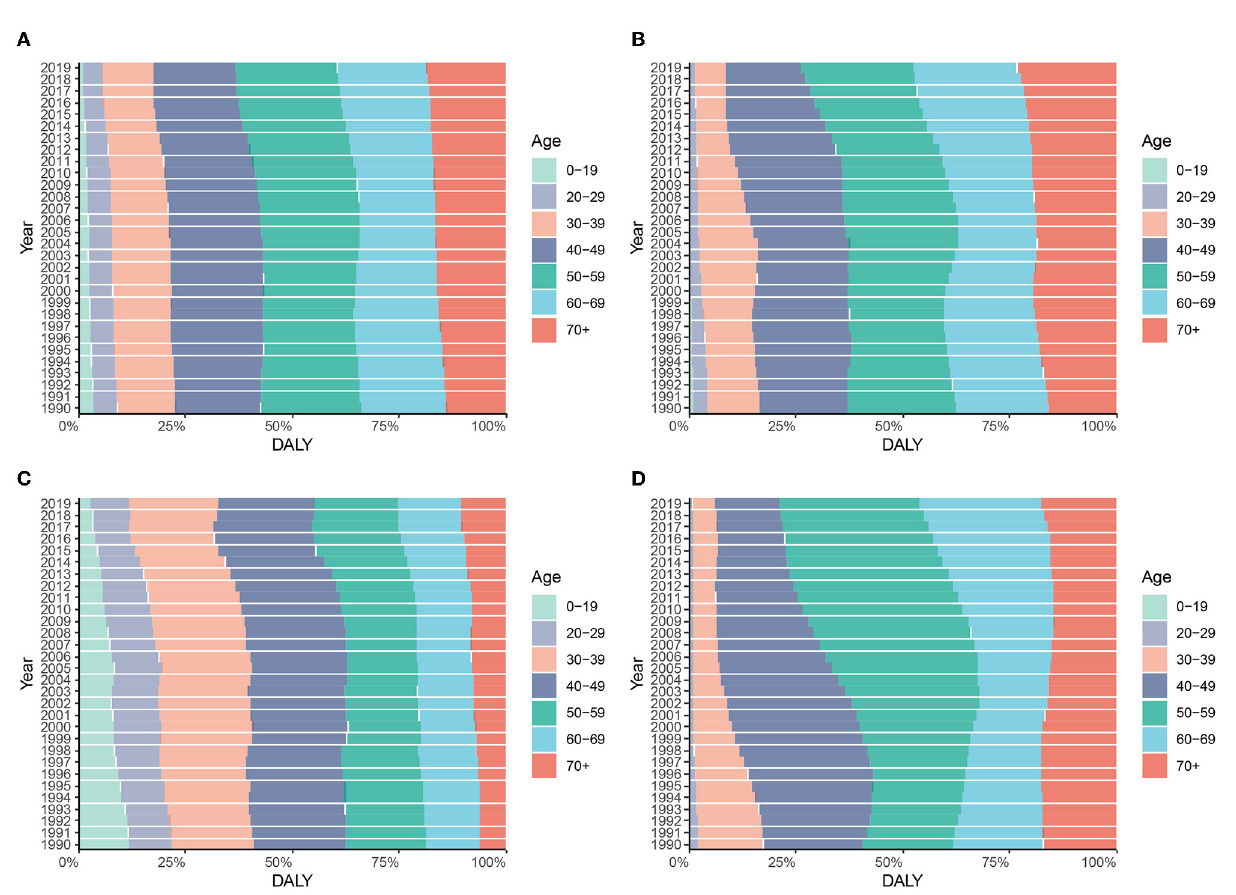
FIGURE6 Constitution of DALYs attributable to HCV by age groups in different regions from 1990 to 2019. (A) Global; (B) China; (C) India; (D) the United